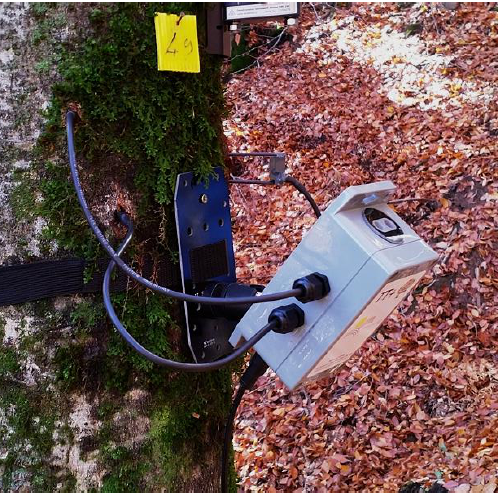
Figure 1. A beech tree monitored with a TreeTalker (power supply not